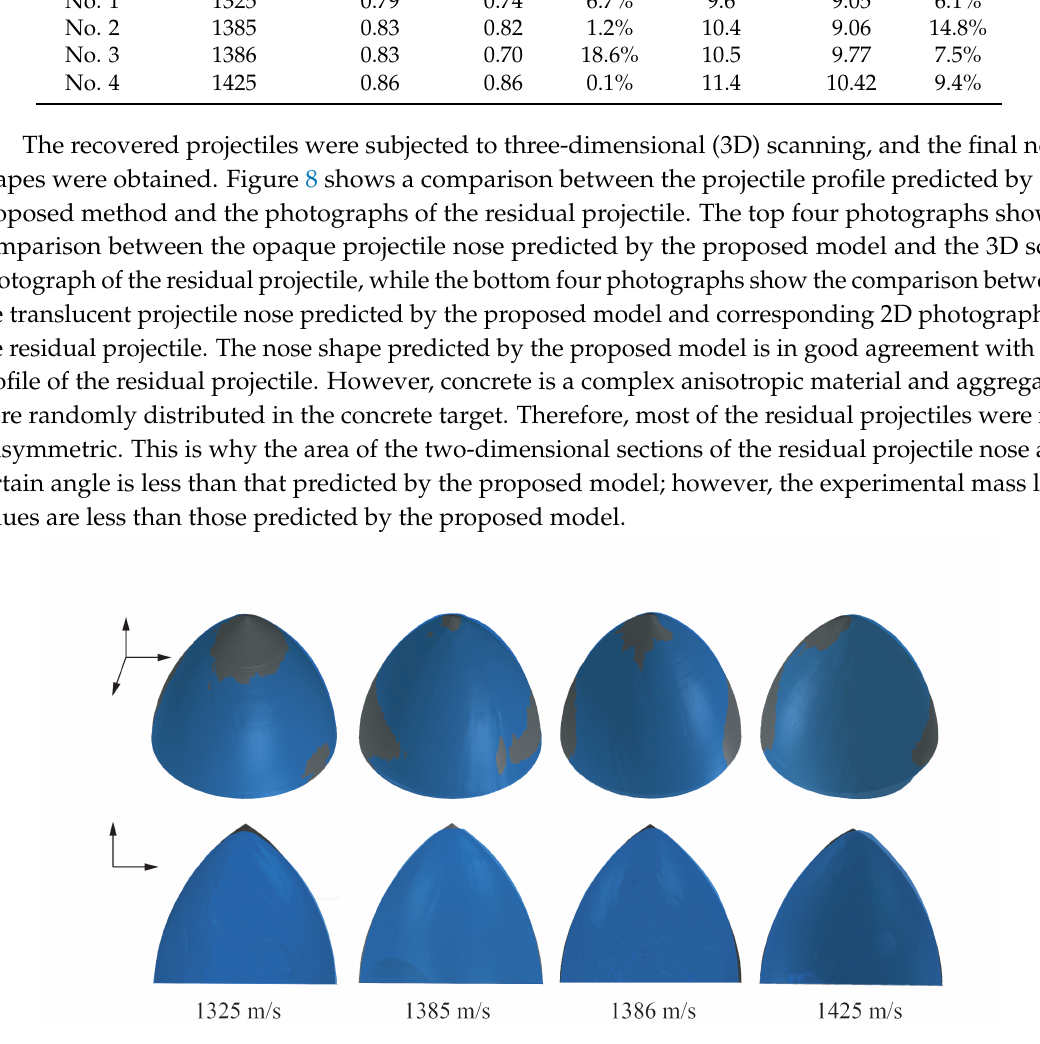
Figure 8. Comparison of the nose shape predicted by the proposed model with the 3D scan photograph of residual projectile. The top four photographs show a comparison between the opaque projectile nose predicted by the proposed model and the 3D scan photograph of the residual projectile. The bottom four photographs show the comparison between the translucent projectile nose predicted by the proposed model and corresponding 2D photograph of the residual